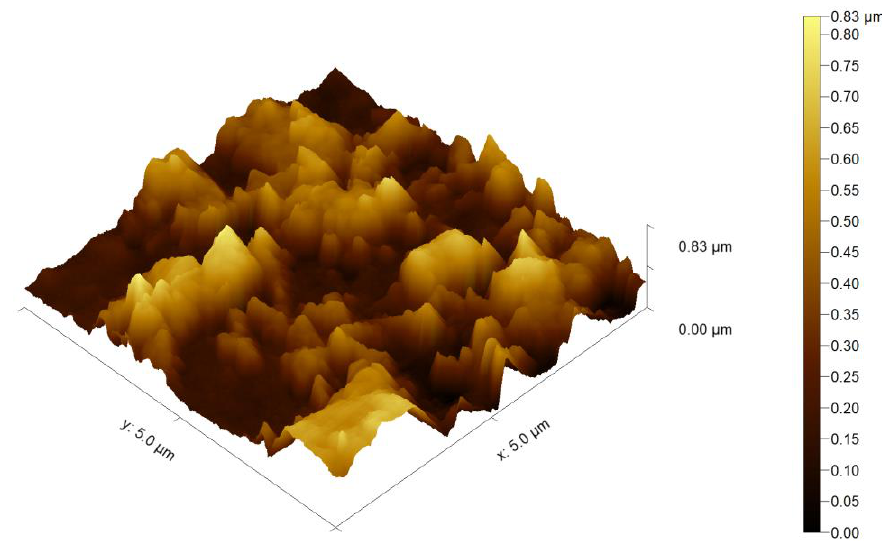
Figure 3. Atomic force microscopy (AFM) micrograph of the surface topography of Bi / Bi 2 O 3 layers.